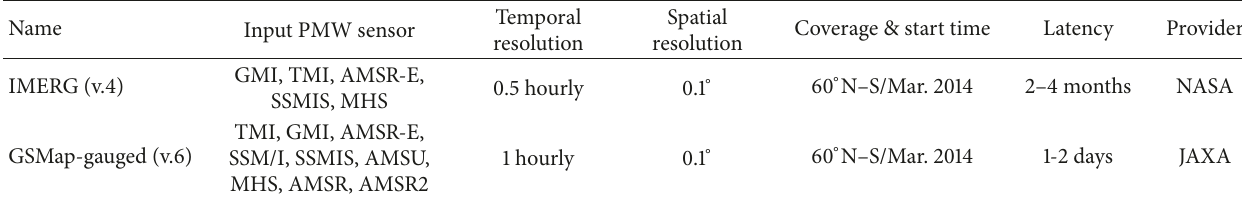
Table 2: Characteristics of the two latest